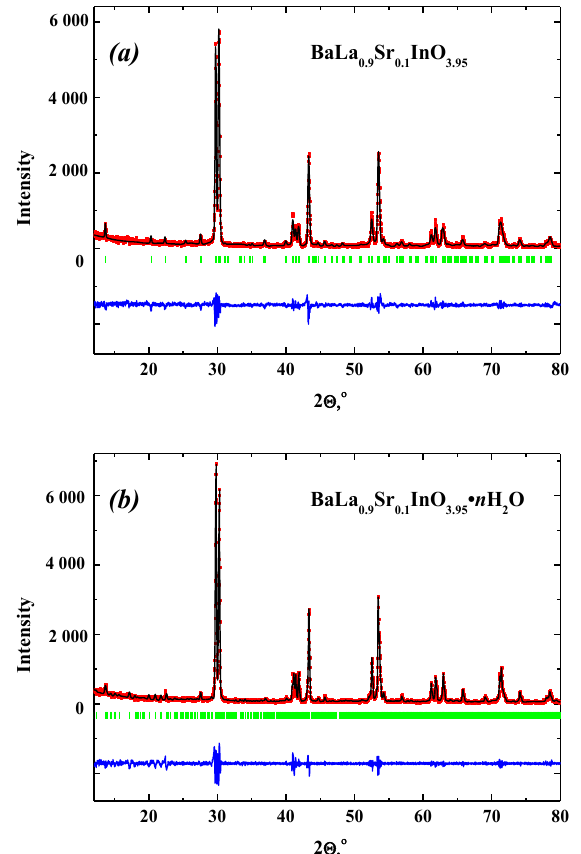
Figure 1. XRD patterns of BaLa 0.9 Sr 0.1 InO 3.95 ( a ) and BaLa 0.9 Sr 0.1 InO 3.95 · n H 2 O ( b ). At the bottom of the figure, the pattern is the difference between the experimental (red) and the calculated one (dark) after refinement. Vertical bars show the Bragg angle positions.